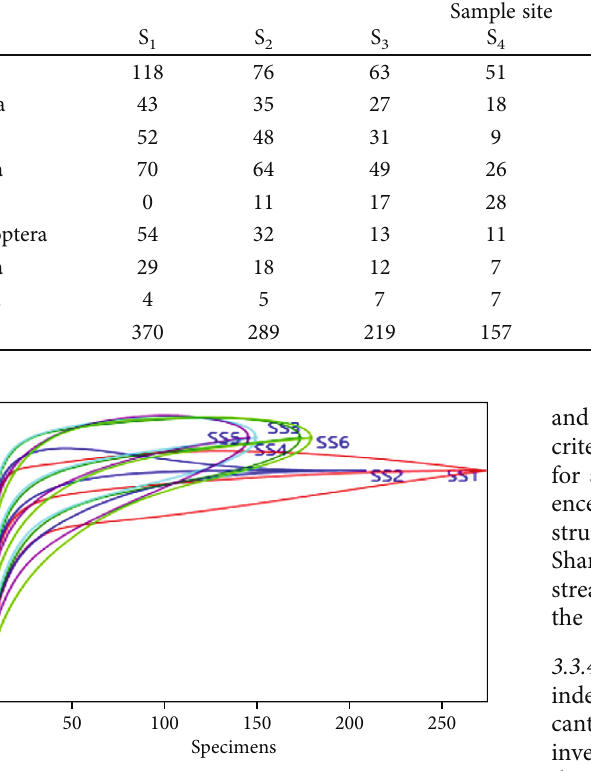
Figure 2: Taxa accumulation curve estimated with 95% con fi dence